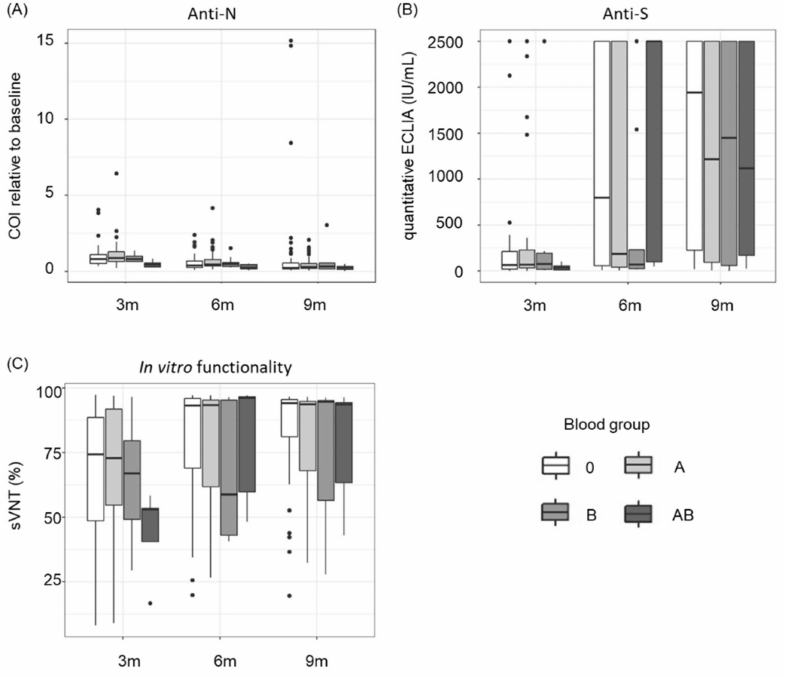
Figure 5. Influence of AB0 blood groups on SARS-CoV-2 antibody dynamics 3, 6 and 9 months after the initial blood donation. ( A ) Blood group AB shows significantly lower cut-off indices (COI) for anti-N overall compared to other blood groups ( p = 0.0335). Data shown are COI of SARS-CoV-2 anti-N total antibodies relative to baseline signal. ( B ) Blood group AB shows substantially lower levels of anti-S antibodies 3 months post initial blood donation and ( C ) lower in vitro functionality of antibodies three months post initial blood donation. Data shown are antibody concentrations in IU/mL for ( B ) and inhibition rates given in percent for ( C